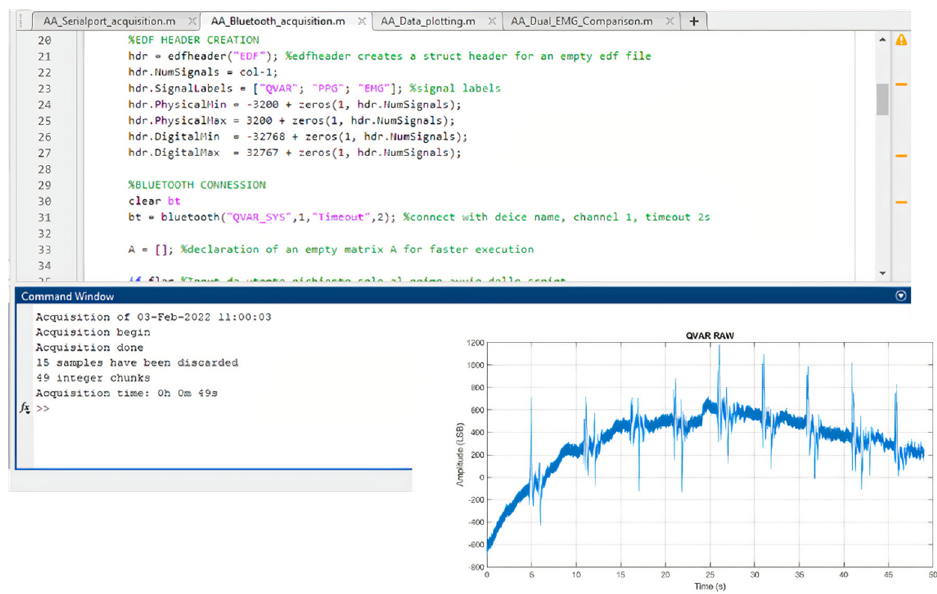
Figure 9. Matlab application interface for data acquisition.